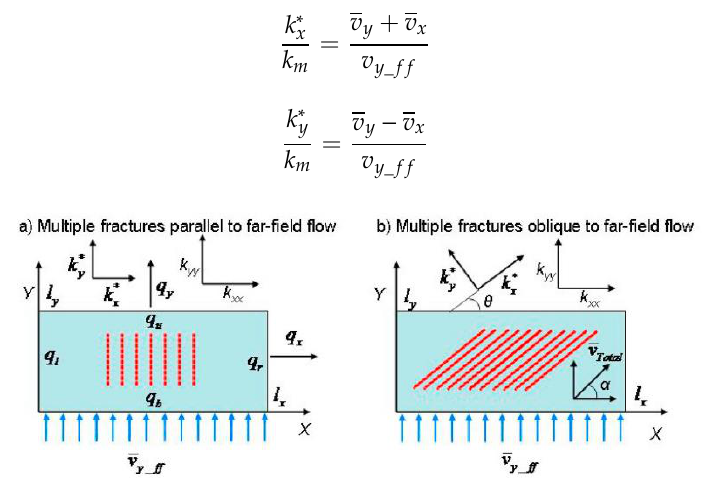
v is the average velocity in the y direction v gives the velocity if the far field